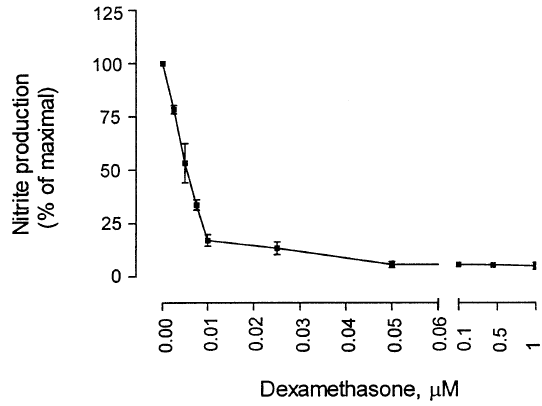
FIG. 1. Dose-dependent effect of dexamethasone on GM- CSF-induced nitrite production in FSDC. FSDC (0.2 (cid:3) / 10 6 cells) were pre-treated for 30 min with a range of concentra- tions of dexamethasone (0.0025 (cid:1) / 1 m M), as indicated, and then stimulated with 100 ng/ml GM-CSF for 48 h. Results were expressed as percentage of maximal nitrite production on the supernatants of cells maintained in culture medium, in the presence of GM-CSF and in the absence of dexa- methasone. Nitrite levels in the culture supernatants were detected by the Griess reaction as described in Materials and methods. Each value represents the mean 9 / standard error of the mean from five